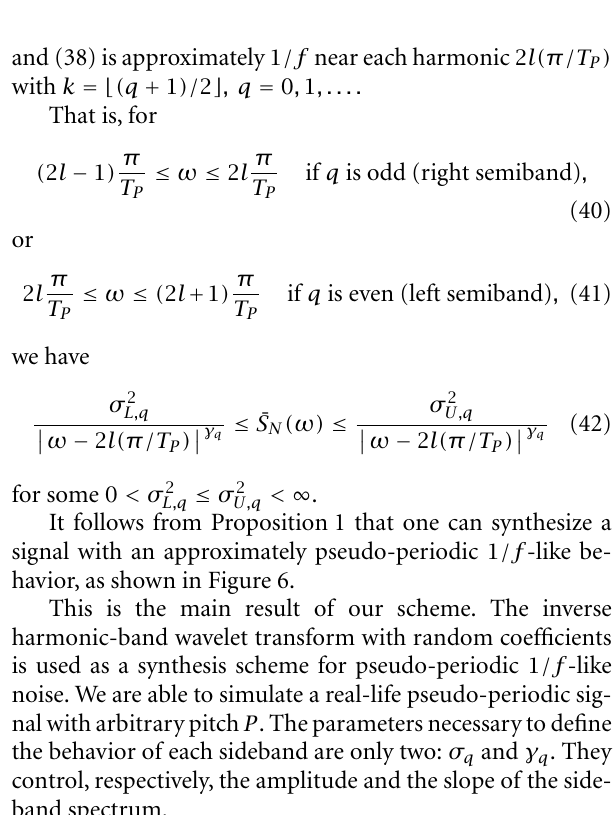
Figure 6: Synthesized pseudo-periodic 1 /f -like noise: three har- monics with different σ q and γ q . (a) solid line: synthesized by DCT and Daubechies wavelet (b) dotted line: synthesized by ideal filter banks (c) dashed line: ideal spectrum